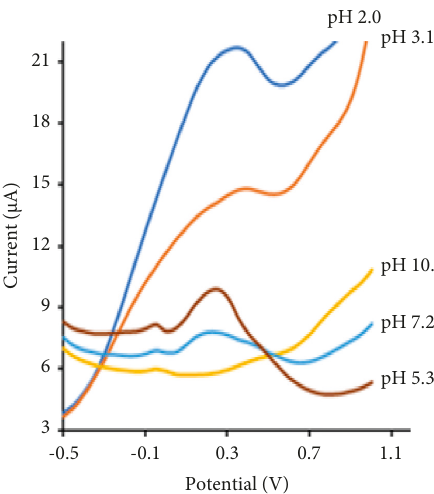
Figure 1: Ads -DP-ASVs of various B-R buffer solutions of pH 2–9.01 in the presence of DCS (10nM) at GCE vs. Ag/AgCl electrode. Scan rate 100mVs − 1 , deposition time (cid:29) deposition ≈